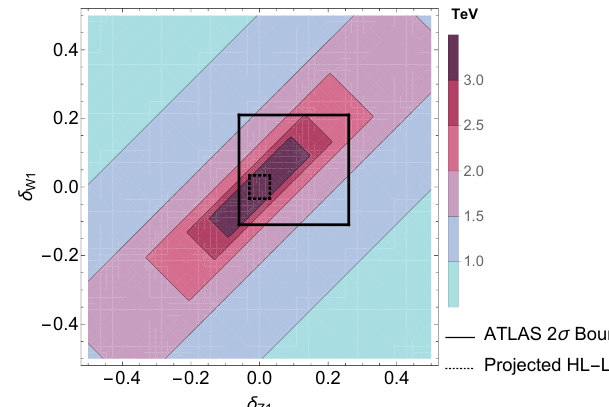
Figure 4 . The unitarity-violating scale that depends on δ Z 1 and δ W 1 assuming that custodial sym- metry is not preserved. The solid black line represents the current ATLAS 95% C.L. constraints [30] while the dotted black line gives the HL-LHC projections